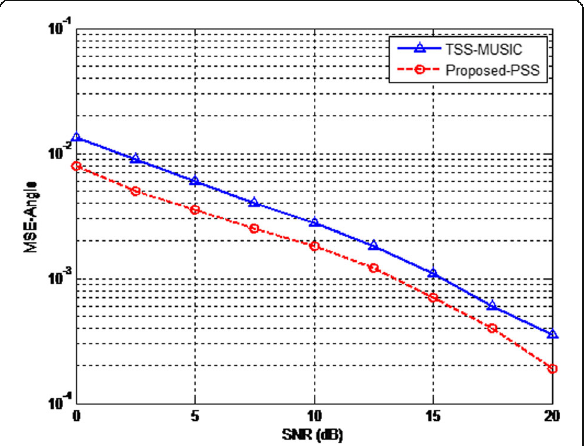
Fig. 10 MSE of angles estimation versus SNR. It plots the MSE versus SNR via 10000 Monte Carlo simulations and shows that the PSS- based angle estimation performs better than the traditional